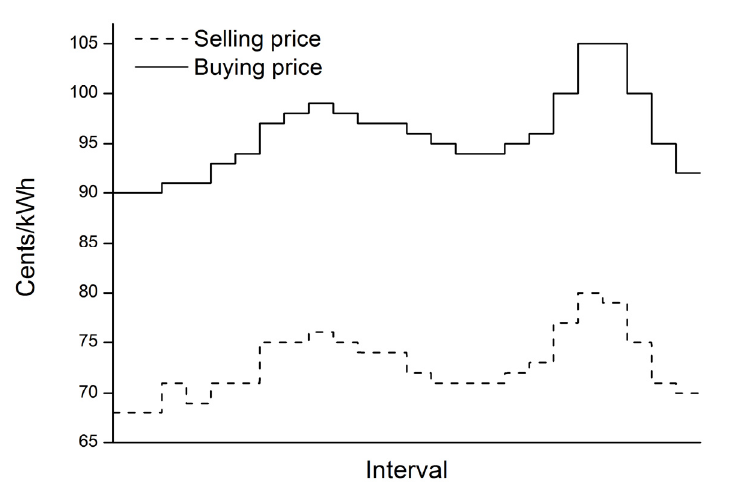
Figure 6. Power trading prices in 24